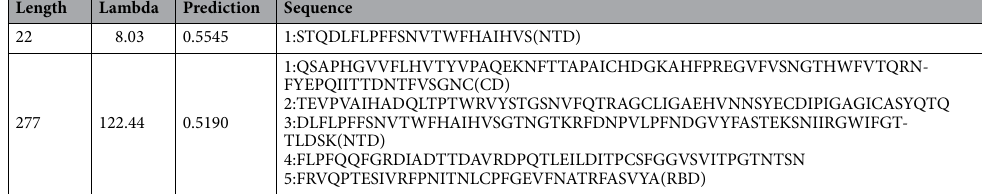
5:FRVQPTESIVRFPNITNLCPFGEVFNATRFASVYA(RBD) Table 2. Optimal weighted λ–superstring, λ values, and VaxiJen overall prediction for the two candidate vaccines with the maximum λ value. Column 1, the number of amino acids in the CVs; column 2, the value of λ; column 3, the VaxiJen overall prediction for antigenicity; column 4, the peptides whose union forms the λ-superstring.